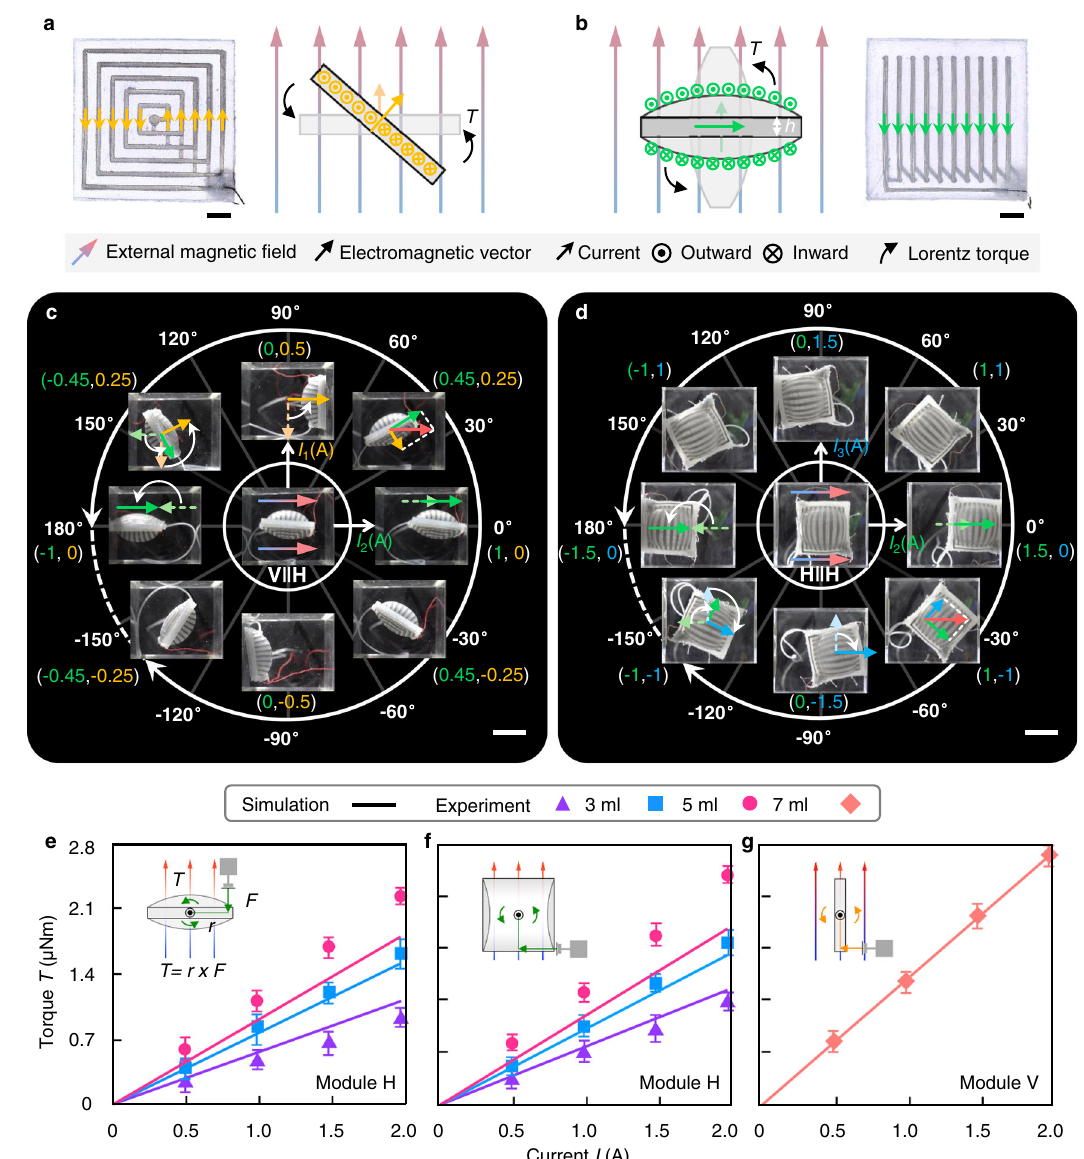
Fig. 3 | Validation and characterization of self-vectoring control for SESRs. a , b Analysis of Lorentz force and motion for the two elementary modules V and H in an ideal parallel magnetic fi eld, respectively. Scale